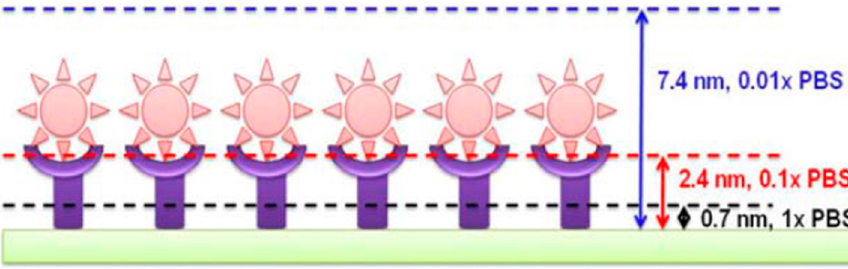
Figure 11. An illustration highlighting how different ionic buffer solution concentrations affect the screening length ( λ D ). Green—sensor platform, purple—bioreceptor, pink—antigen. Reprinted from